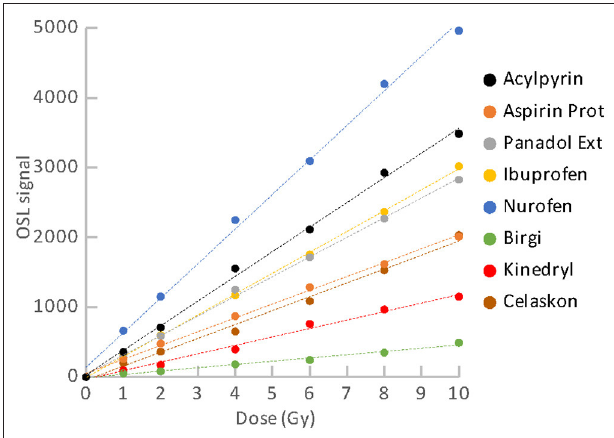
FIGURE 9 | Dose response for the group of pharmaceuticals and vitamin C.